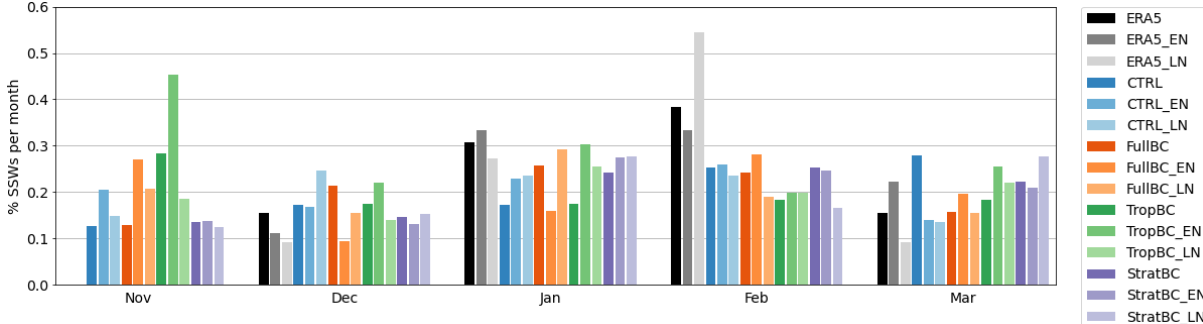
Figure 5. Monthly distribution of SSW frequencies for neutral, El Niño, and La Niña years. The bars are normalized by dividing the number of SSWs in each month by the total number of SSWs for each experiment. ERA5 data from 1979–2019, 100 years for each model run (neutral, El Niño, and La